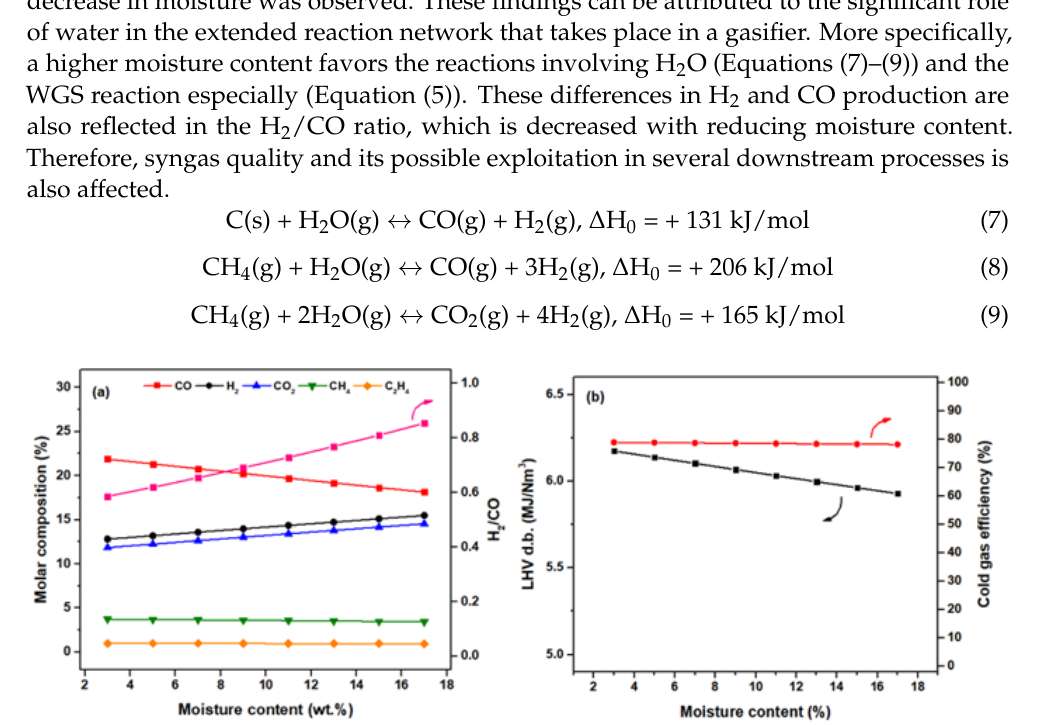
Figure 12. Effect of residual biomass moisture on syngas composition ( a ) and LHV (dry basis) and cold gas efficiency ( b ). Reaction temperature = 834 °C.